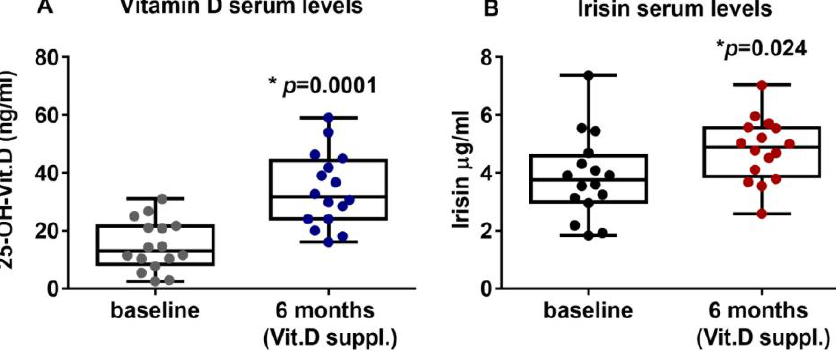
Figure 1. After six months of treatment with vitamin D (cholecalciferol), PHPT patients with hypo- vitaminosis D showed increased serum levels of 25-OH-Vitamin D ( A ) and irisin ( B ). Data are pre- sented as box-and-whisker plots with median and interquartile ranges, from max to min, with all data points shown. Mann – Whitney test was used to compare groups. p value as indicated; * signif- icant p value.